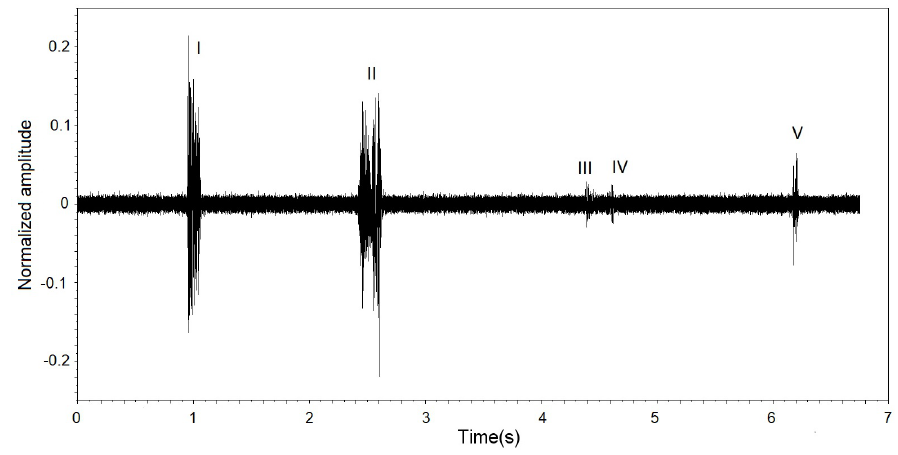
Figure 10. Signal extract captured with brightness fluctuations in I, II, III, IV and